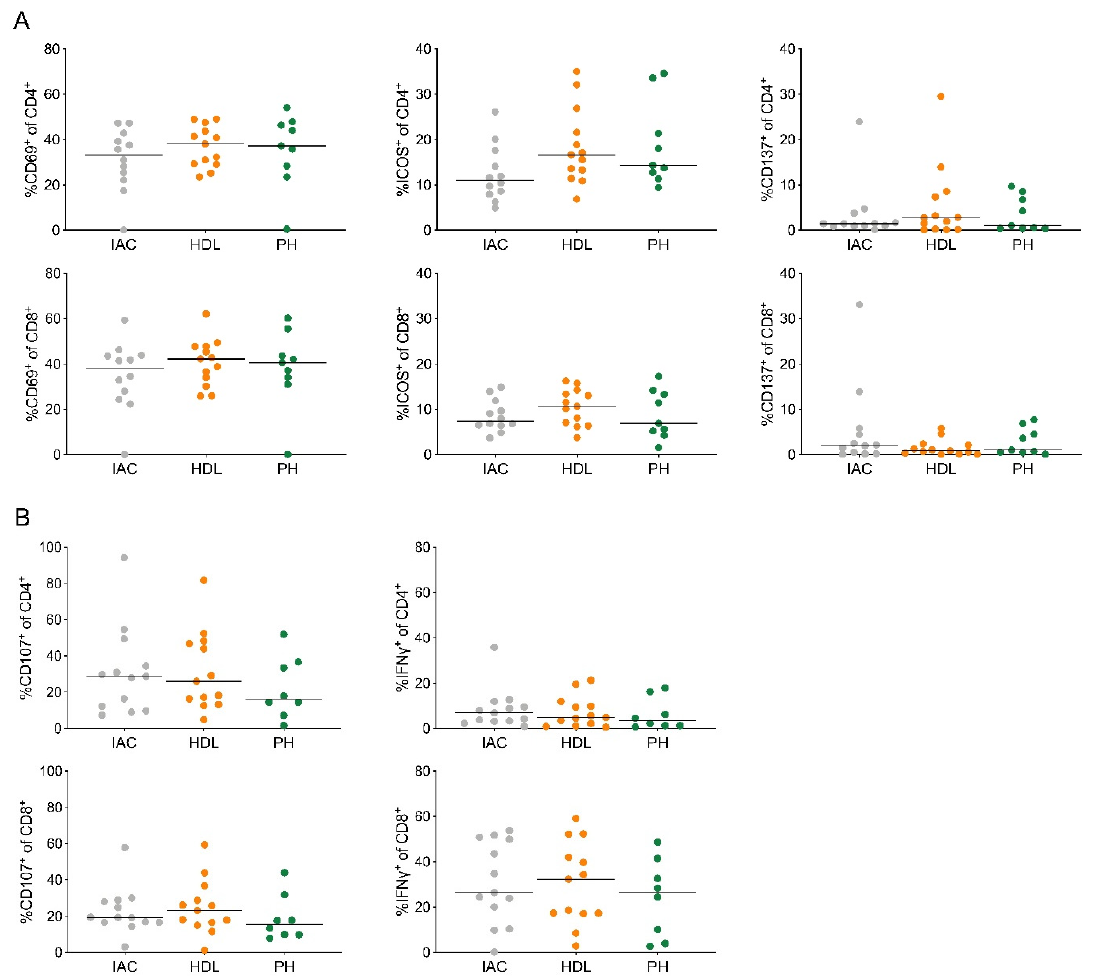
Figure 3. Lymph node CD4 + and CD8 + T cells display a similar degree of activation independent of distance from the tumor. ( A ) Quantification of the expression of the activation markers CD69 (left), ICOS (middle) and CD137 (right) on CD4 + (top) and CD8 + T cells (bottom). ( B ) Quantification of CD107a (left) expression and IFN γ (right) secretion by stimulated CD4 + (top) and CD8 + T cells (bottom). IAC, interaortocaval; HDL, hepatoduodenal ligament; PH, pancreatic head. Each point represents data from one patient. Data, median. One-way ANOVA.